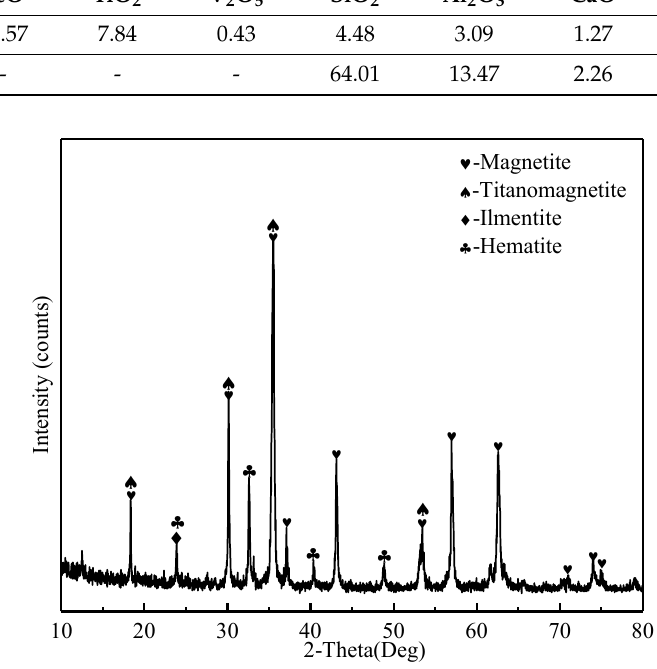
Figure 1. XRD pattern of the vanadium titanomagnetite.